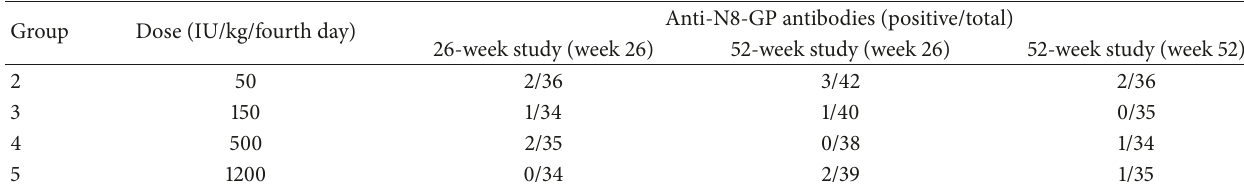
Table 6: Anti-N8-GP antibodies detected in animals during the dosing